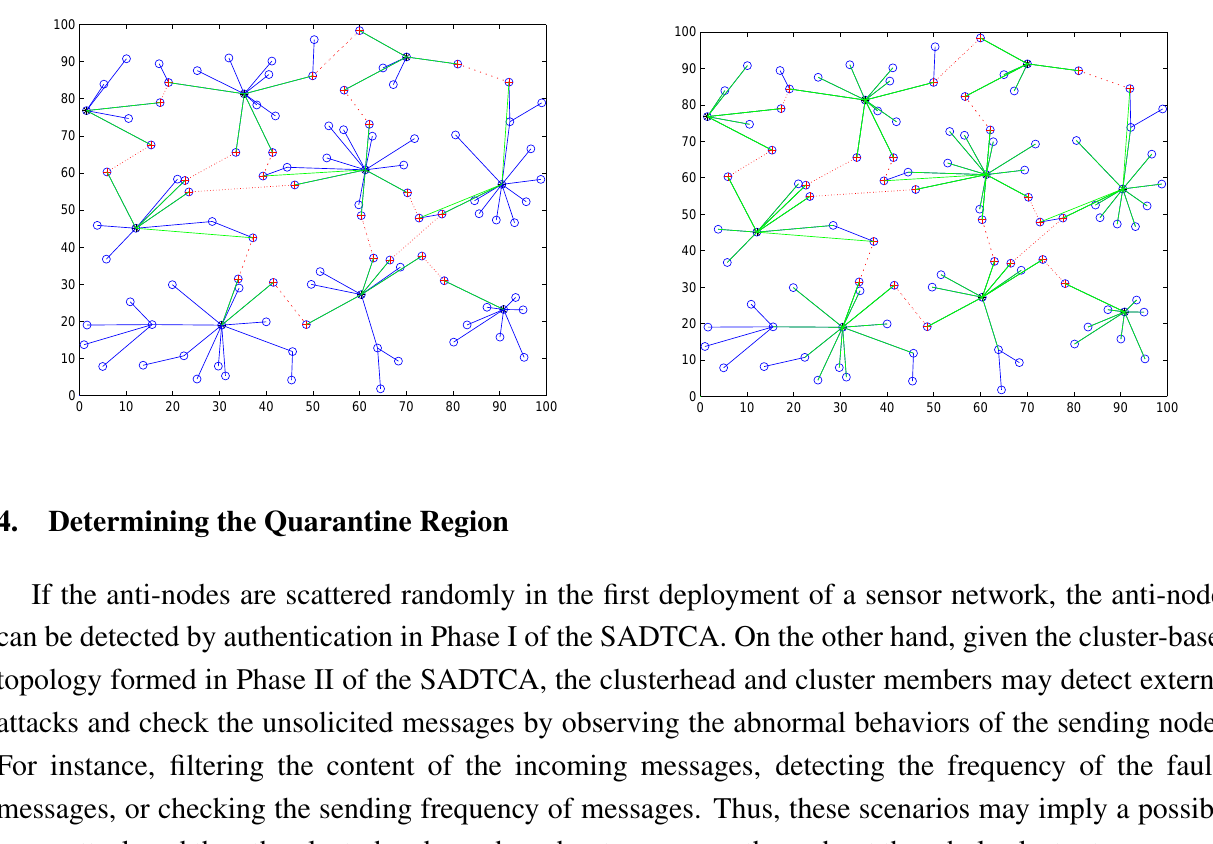
Figure 3. Key renewal process: the originator sends the renewal index to other clusterheads through gateways (left); the clusterheads send the renewal index to their cluster members